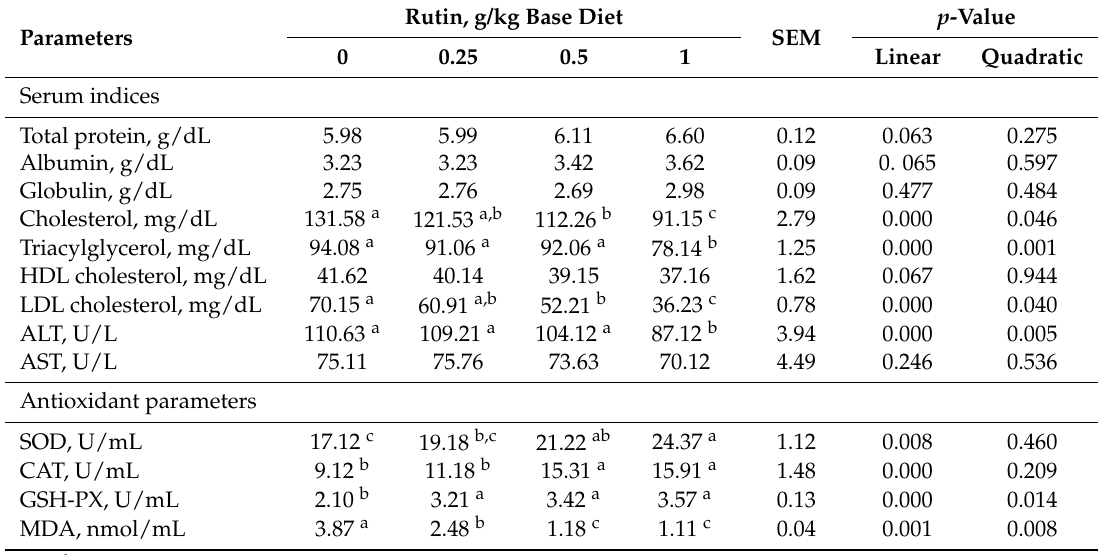
Table 5. Effect of dietary rutin on serum biochemical and antioxidant parameters of broiler chickens. Parameters